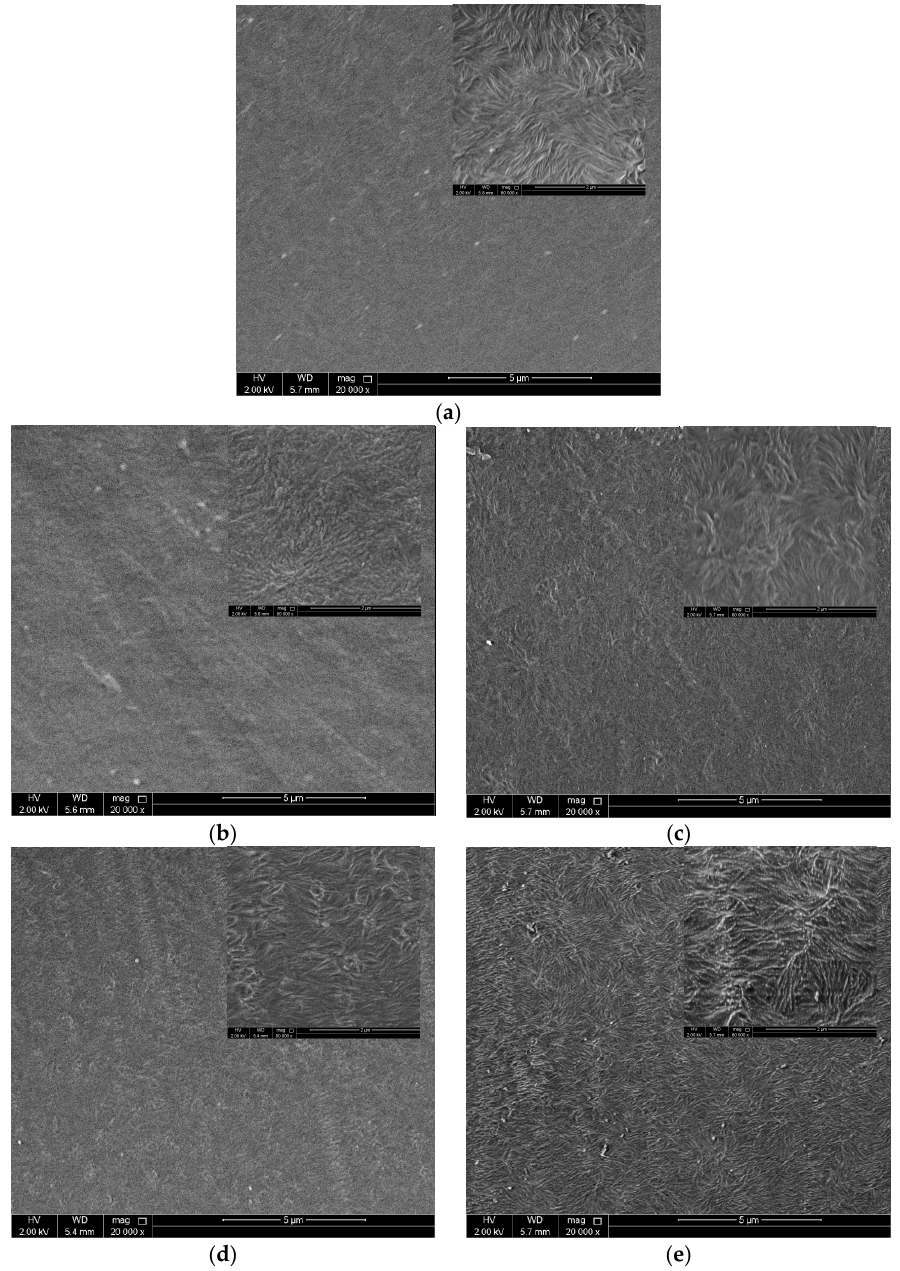
Figure 21. SEM images at 20000× magnification of LDPE films: ( a ) untreated; ( b ) treated in oxygen; ( c ) treated in nitrogen; ( d ) treated in argon; ( e ) treated in air.